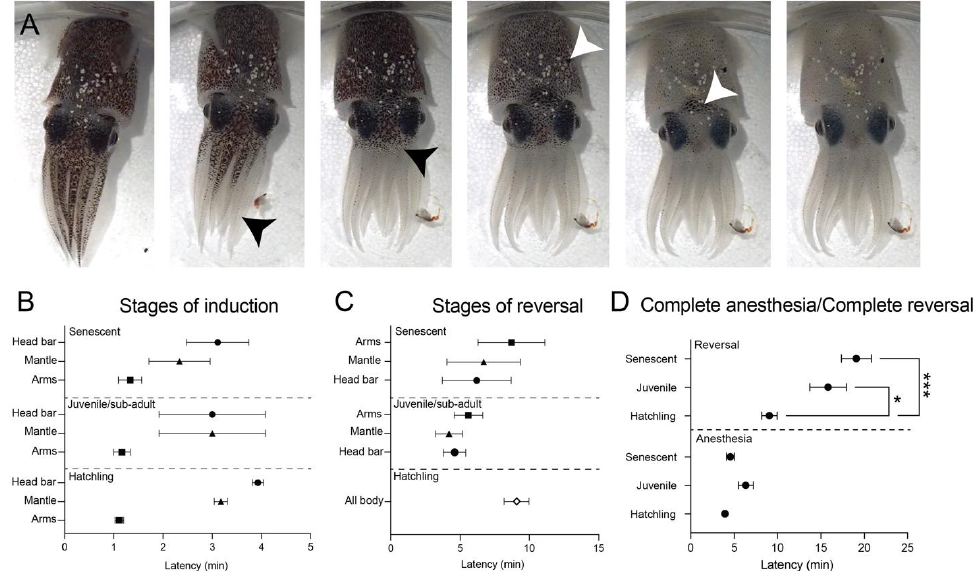
Figure 6. General anesthesia in multiple age-classes of E. berryi with a combination of 1% EtoH ( v / v ) and 1:3 ratio of isotonic MgCl2:SW. ( A ) Photographic sequence showing progressive outward signs of anesthesia induction. In all age classes paling of the arms progressed from tip to base (Black arrowheads), which was followed by all-over mantle paling (white arrowhead, 4th panel) and finally relaxation of chromatophores across the head-bar, between the eyes (5th panel). Once squid were completely pale, we tested for complete anesthesia by recording absence of response to visual stimulation, vibratory stimulation, or light touch on the body surface. Latency between complete paling and full anesthesia was variable. ( B ) Comparisons among the three age classes tested showed no significant differences in latency to paling of arms, mantle or head bars. ( C ) Reversal times were counted from the point where solutions were changed to fresh seawater. Return of chromatophore tone followed the reverse order of induction. In hatchlings we were only able to reliably identify whole-body darkening on recovery. No significant differences between age classes were found. ( D ) Latency to complete anesthesia and complete reversal wee compared among the age classes. No differences in induction times were found, but hatchlings recovered significantly faster than juve- nile and senescent squid (one-way ANOVA followed by post-hoc Bonferroni corrected t -tests,